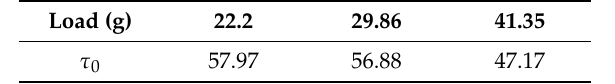
Table 2. Summary of exponential fitting parameter τ 0 with di ff erent